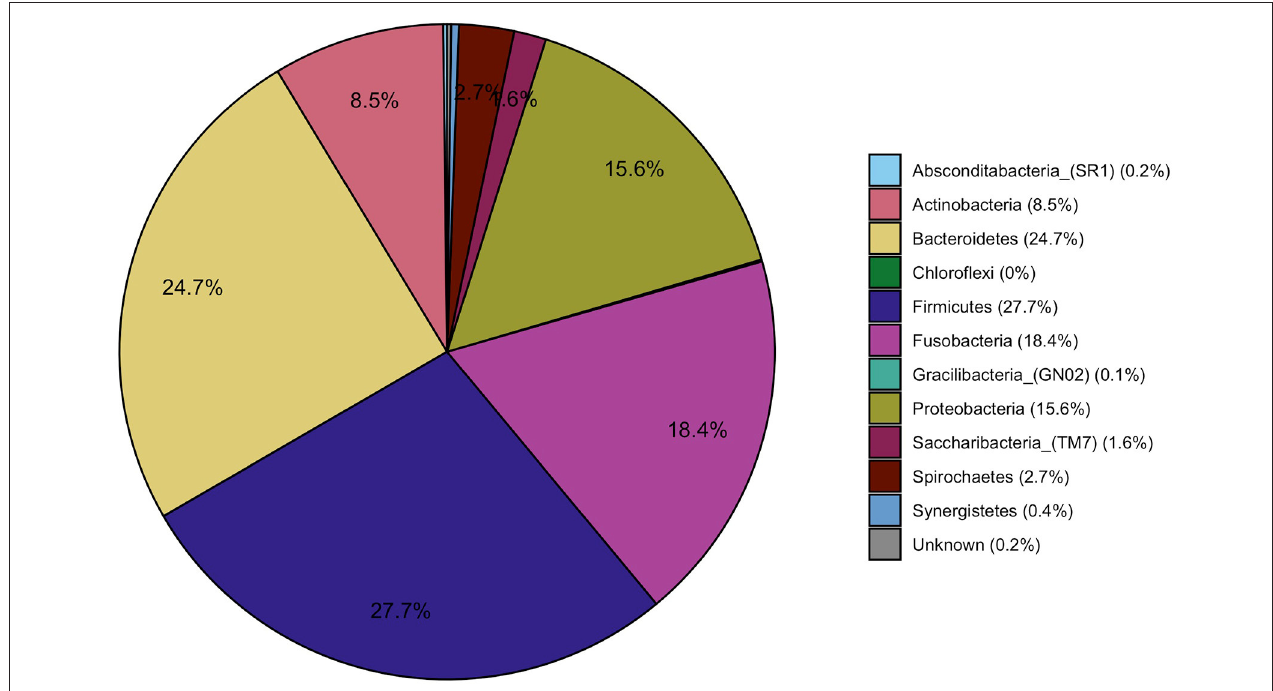
FIGURE 4 | Pie charts representing the main phyla that constitute the oral microbiome in the study population.